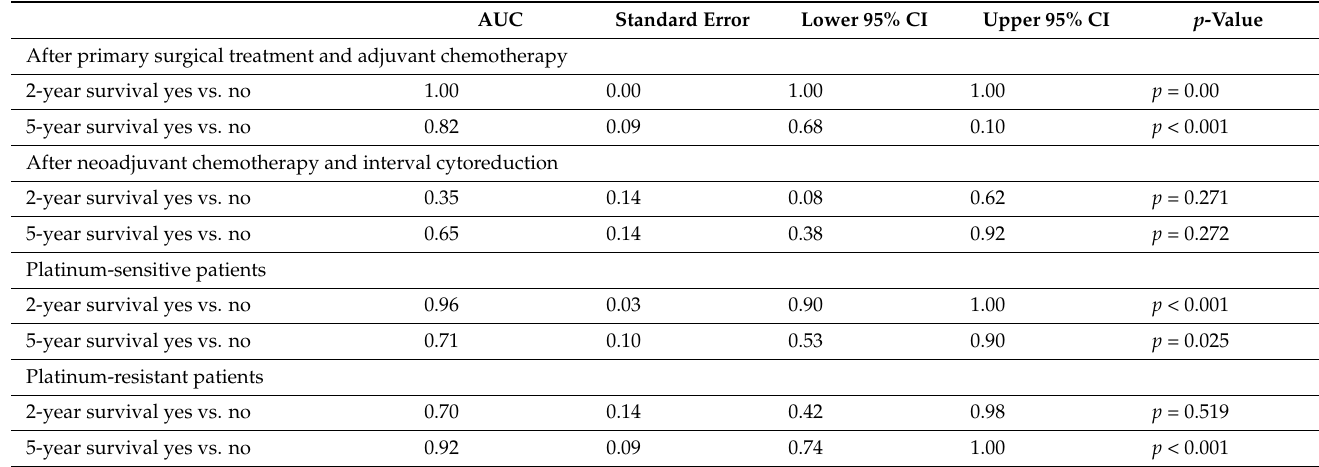
Table A4. Assessment of serum HE4 prognostic value at the time of diagnosis of II relapse.